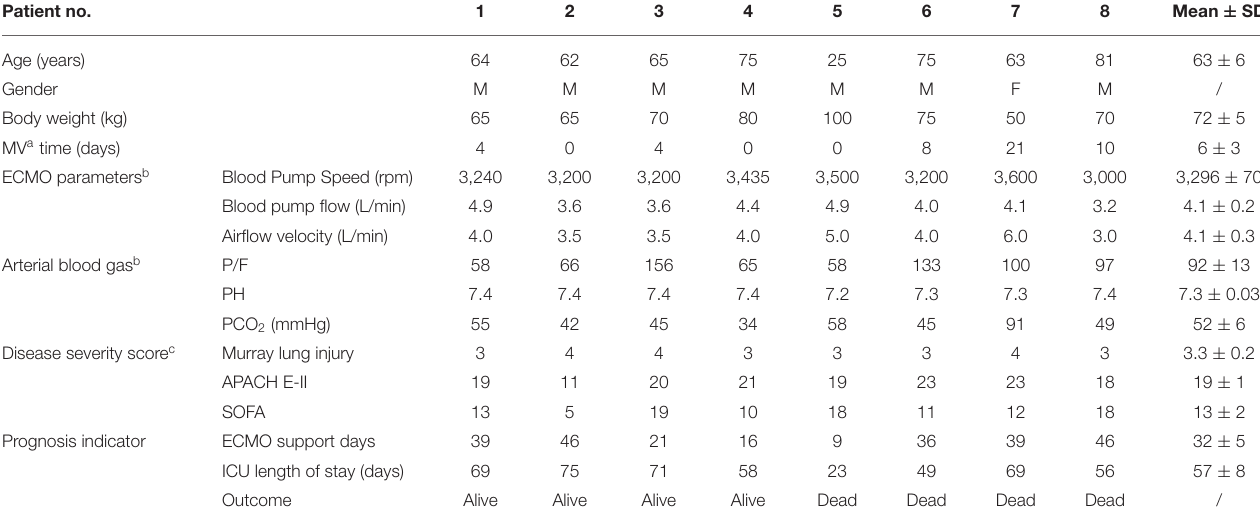
TABLE 1 | Patients’ clinical characteristics. Patient